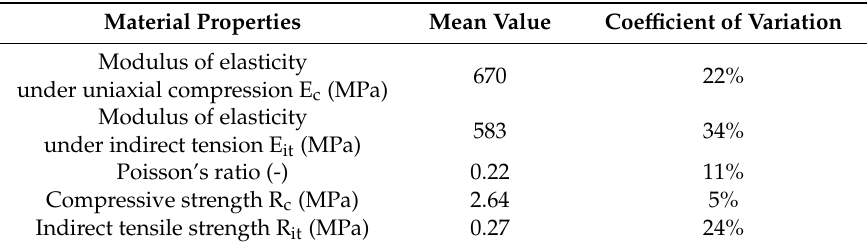
Table 2. Mechanical properties of the tested soil [40].